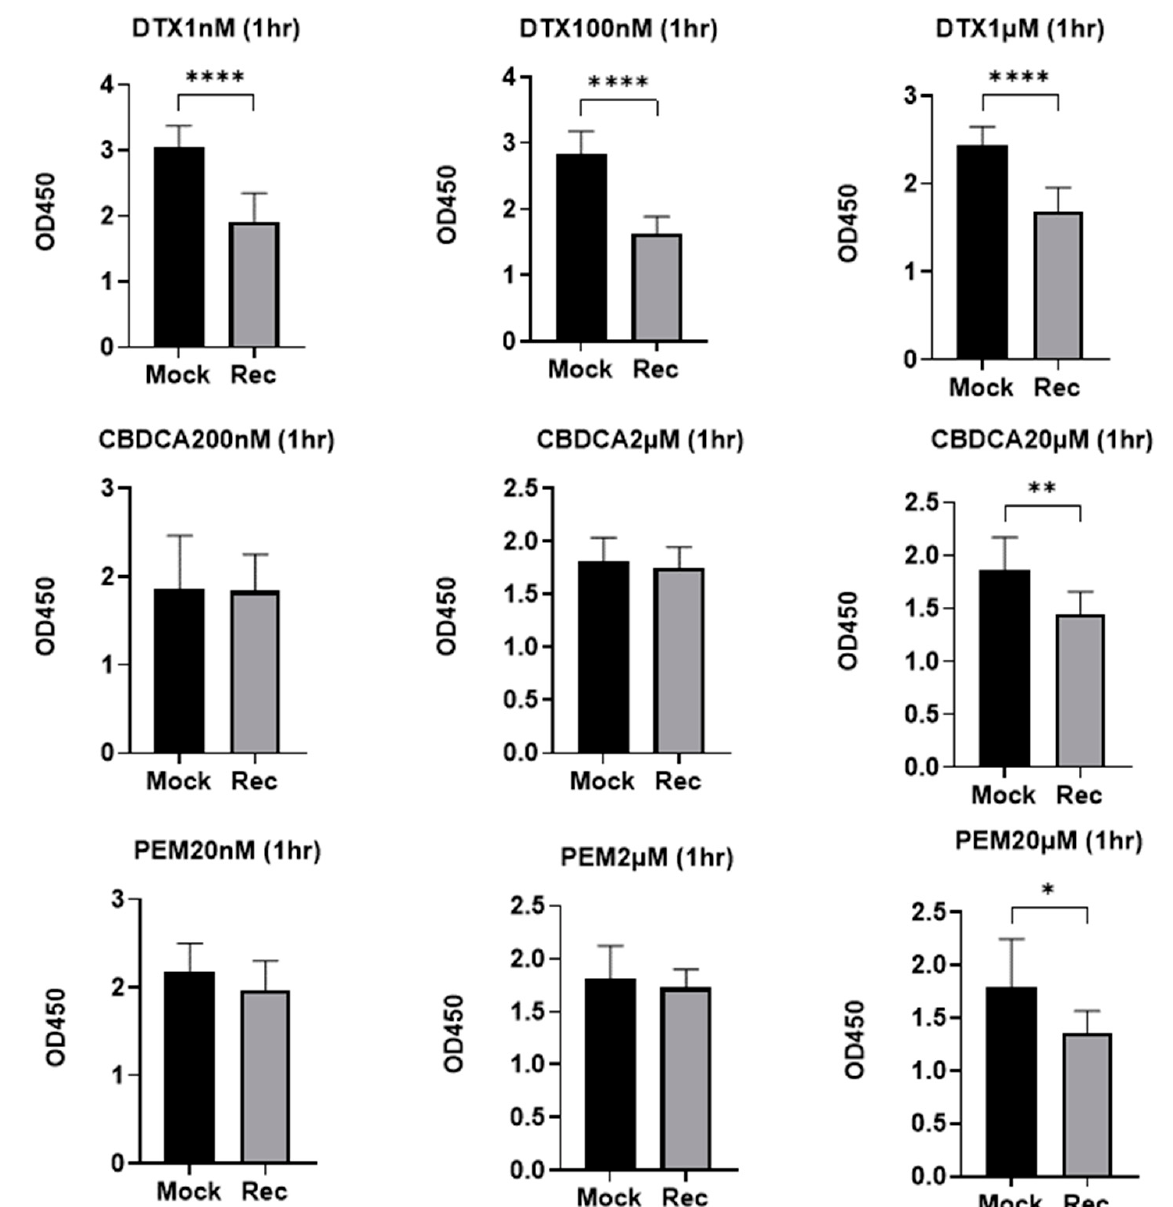
Figure 1. Cytotoxicity caused by several anti-tumor agents toward A549 MOCK and A549 Rec. To estimate the cytotoxic effects of several anti-tumor agents at different concentrations, including decetaxel (DTX; 1 nM, 100 nM and 1 µ M), carboplatin (CBDCA; 200 nM, 2 µ M and 20 µ M), and pemetrexed (PEM; 20 nM, 2 µ M and 20 µ M) on 2D-cultured A549 MOCK and A549 Rec, the survival of the Cells was evaluated by means of a Cell Counting Kit-8, (Dojindo, Tokyo, Japan) according to the manufacturer’s protocol. Briefly, after culturing 2D cells (5000 cells/well) for 18 h in the absence or presence of each anti-tumor agent, they were incubated with 10 µ L of reactive solution for 1 h. The absorbance of each cell at 450 nm was measured using a microplate reader (multimode plate reader EnSpire ® , PerkinElmer, Waltham, MA, USA) and plotted (n = 4). Data are expressed as the mean ± the standard error of the mean (SEM). * p < 0.05, ** p < 0.01, **** p < 0.001 (Student’s t -test).